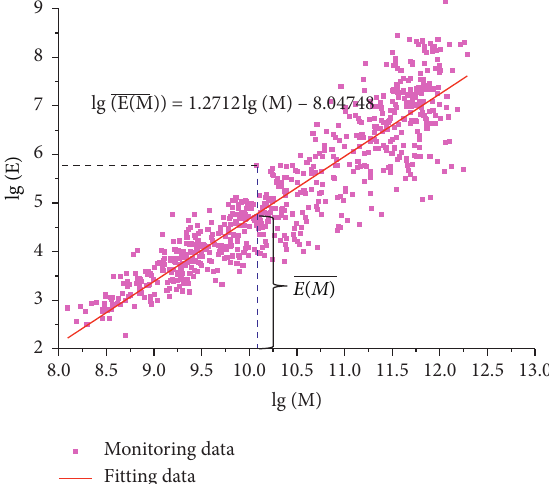
Figure 13: Relationship between the energy and seismic moment of the MS